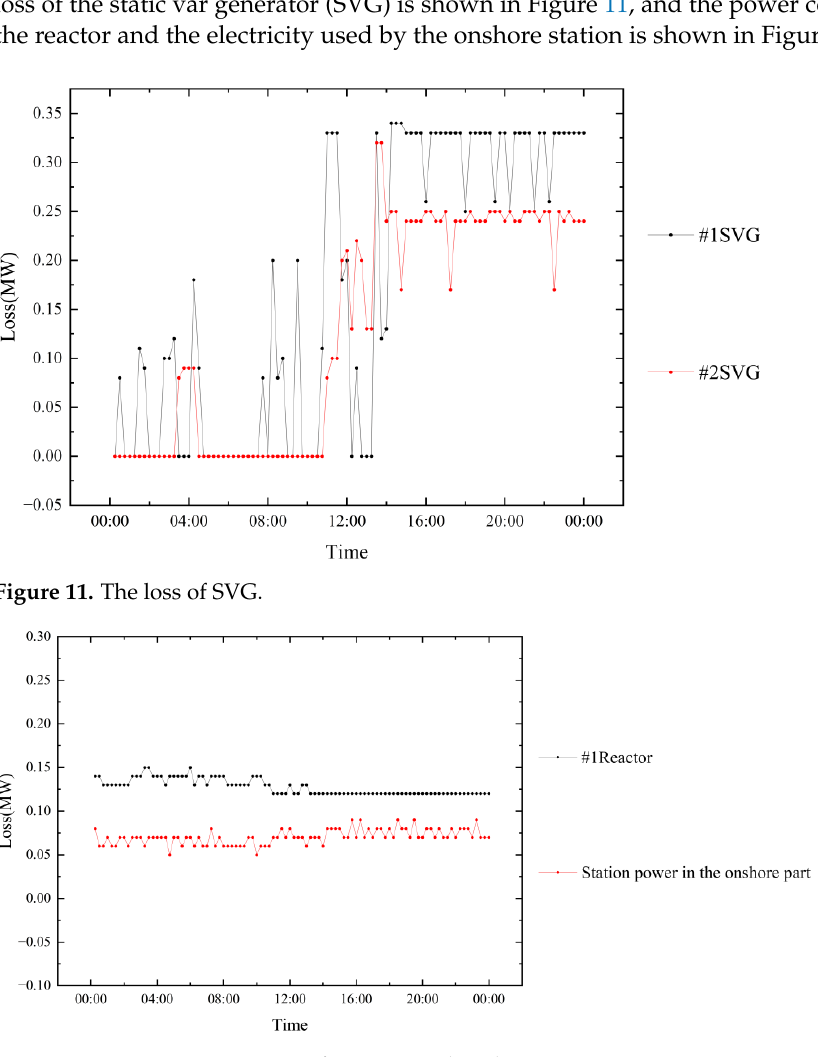
Figure 12. Power consumption of reactors and onshore stations.